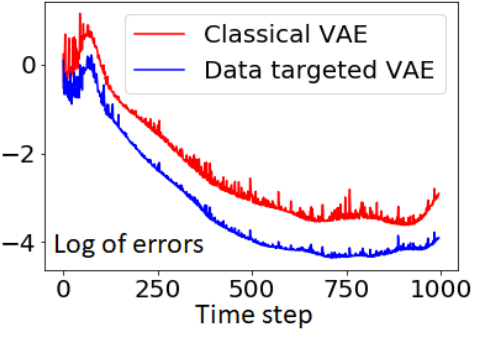
(cid:107) µ ( t ) − u ( t ) (cid:107) 2 i i h h ) for the classical VAE; in blue: log ( (cid:107) u ( t ) (cid:107) 2 i h